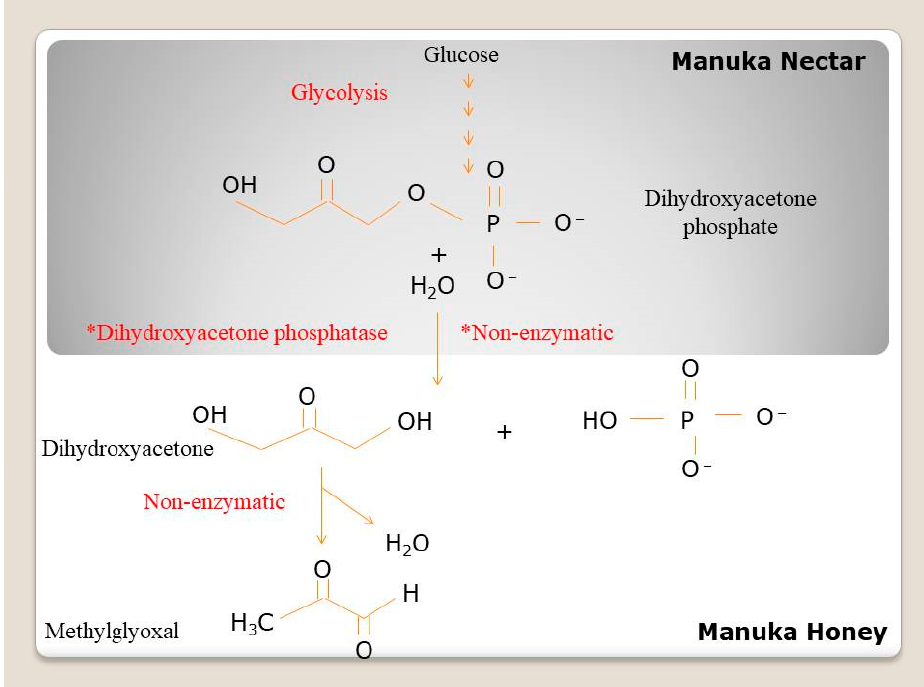
Figure 4. Production of methylglyoxal in Manuka honey